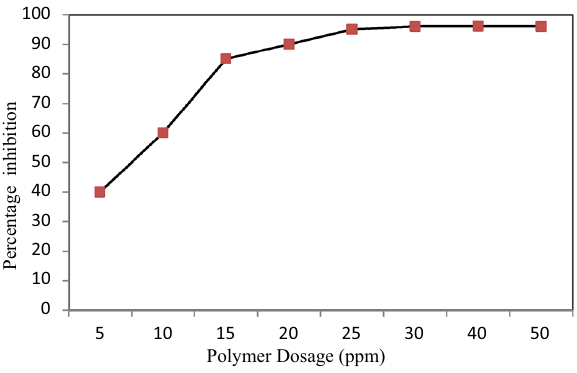
Fig. 6 Effect of MA-SMADS copolymer dosage on Barium sulfate scale inhibition